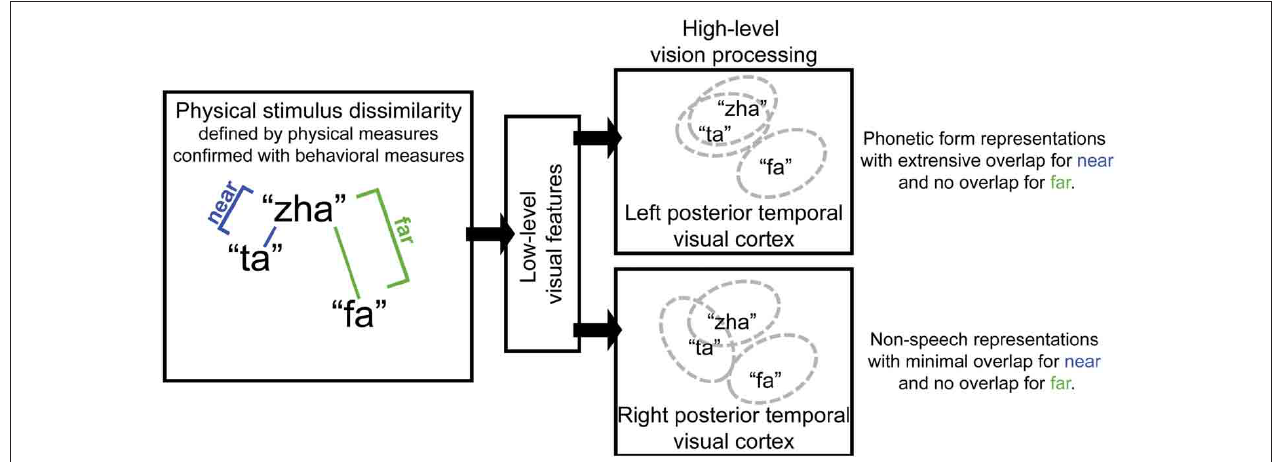
FIGURE 1 | Schematic diagram of the proposed roles for left and right posterior temporal cortices in visual speech perception. Left posterior temporal visual cortex is hypothesized to represent phonetic forms that support eventual phoneme categorization and to therefore be invariant to variation in facial motion that is unlikely to reliably support speech perception. Pairs of visual speech syllables are predicted to activate largely overlapping populations of neurons in left posterior temporal cortex when the syllables in the pair are perceptually similar